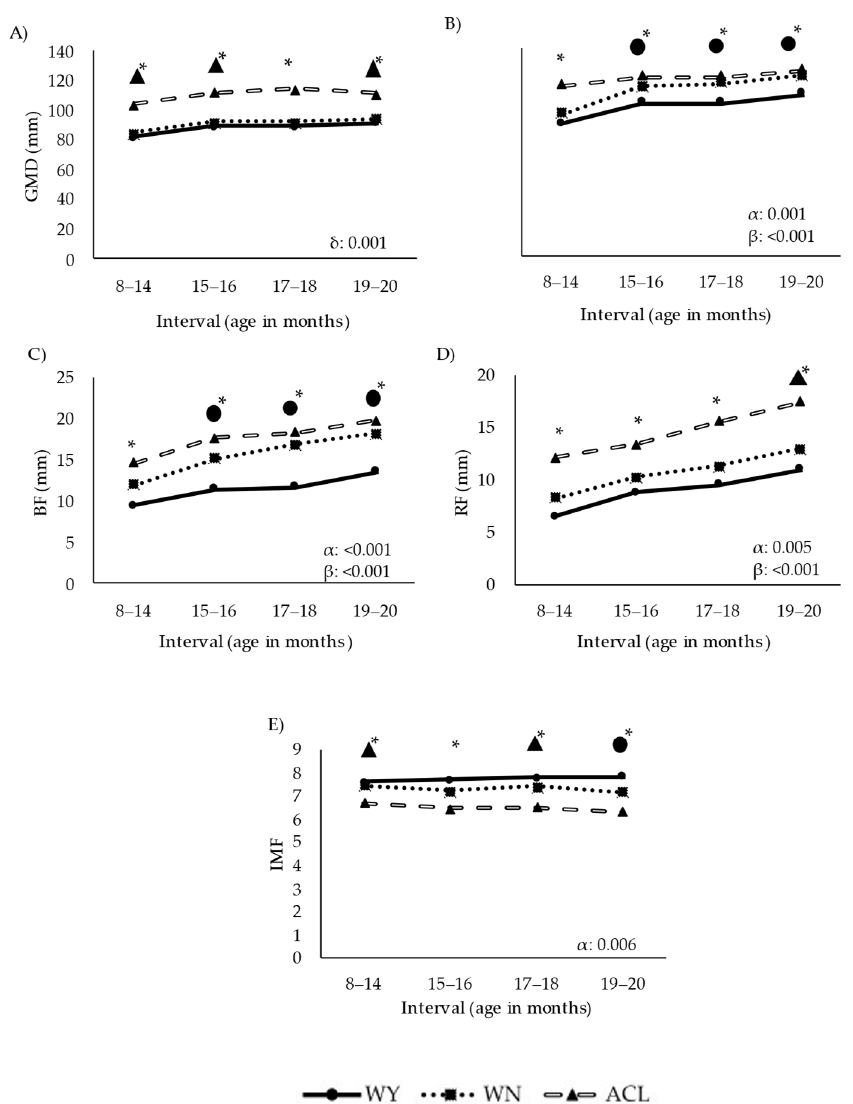
Figure 4. Longitudinal approach of ultrasound estimates of fat and muscle deposition over time in steers during the fattening period. Abbreviations: Panel ( A ): GMD, depth of the gluteus medius muscle measured at point “P8” rump site; Panel ( B ): REA, ribeye area of the longissimus dorsi measured between the 12–13th ribs; Panel ( C ): BF, back fat thickness measured between the 12–13th ribs; Panel ( D ) RF, rump fat thickness at the “P8” rump site; Panel ( E ): IMF, intramuscular fat estimation (numerical values provided by the software); ACL, crossbred Angus-by-Charolais or Angus-by-Limousin; WN, Wangus animals (Wagyu-by-Angus) breed; WY, fullblood Wagyu animals. One asterisk indicates that all breeds differed significantly from one another ( p < 0.001). ● * indicates that the breed WY differed significantly from the other two ( p < 0.001). ▲ * indicates that the breed ACL differed significantly from the other two ( p < 0.001). α indicates significant effect of breed; β indicates significant effect of time; δ indicates significant effect of the interaction between breed and time. Parameters are expressed as median values.